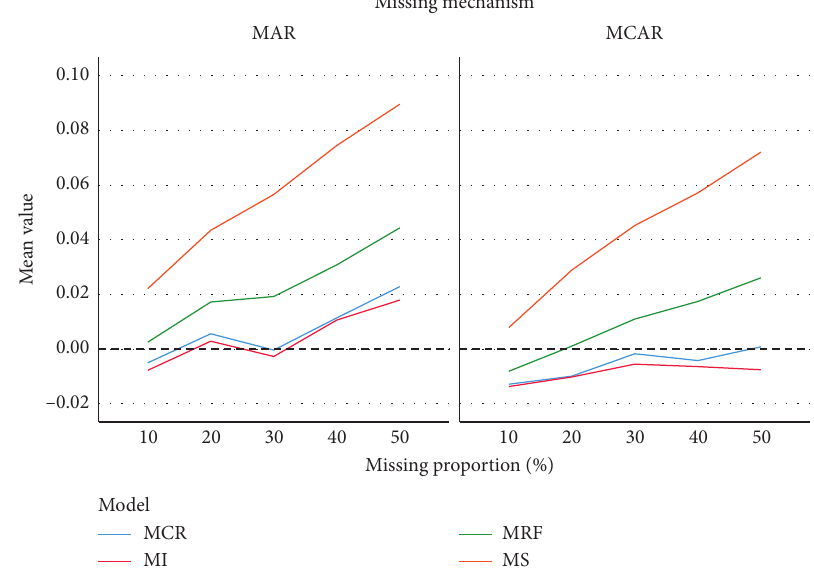
Figure 1: Comparison of the performance of imputation methods for real dataset based on the average raw bias (RB) for the interaction effect. MAR, missing at random; MCAR, missing completely at random; MCR, multiple imputation by chained equation using classification and regression trees; MRF, multiple imputation by chained equation using random forests; MI, MICE-Interaction method; MS, MICE- Stratified